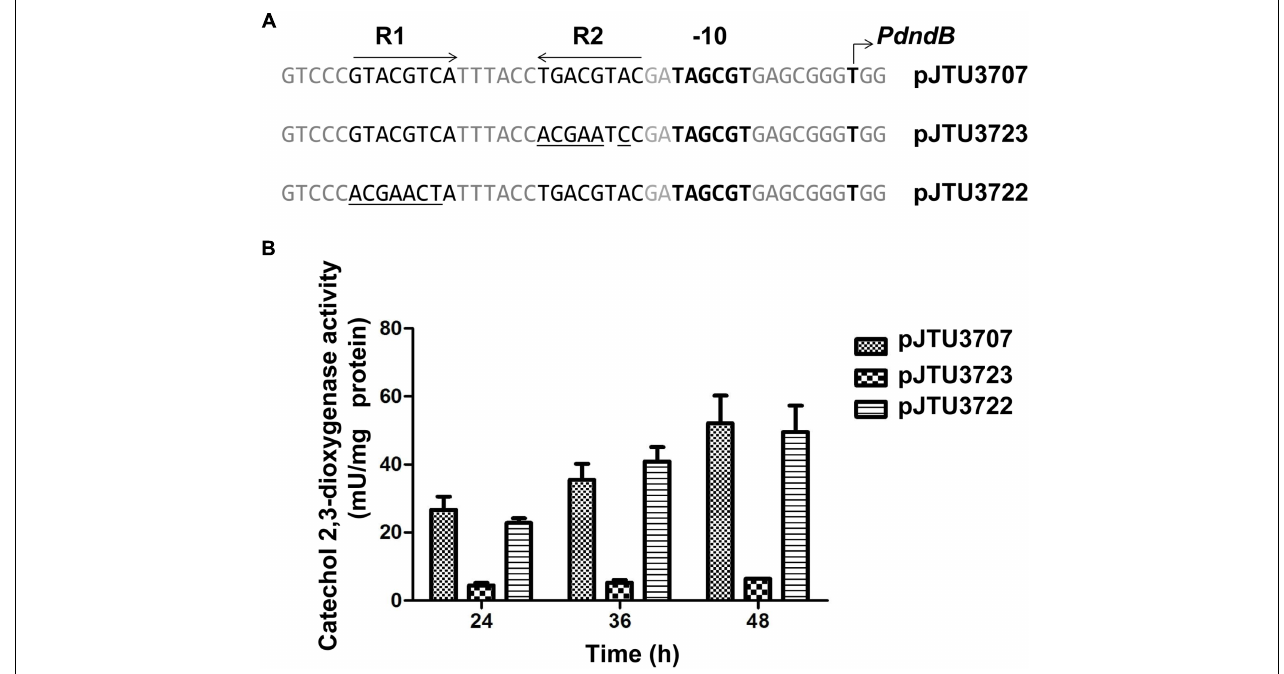
FIGURE 5 | Analysis of mutations within R1 or R2 in dndB promoter region. (A) Alignment of native dndB promoter with its derivatives possessing base substitutions within R1 or R2 (the base substitutions in the derivatives are underlined). (B) Histogram showing results of quantitative catechol 2,3-dioxygenase assays